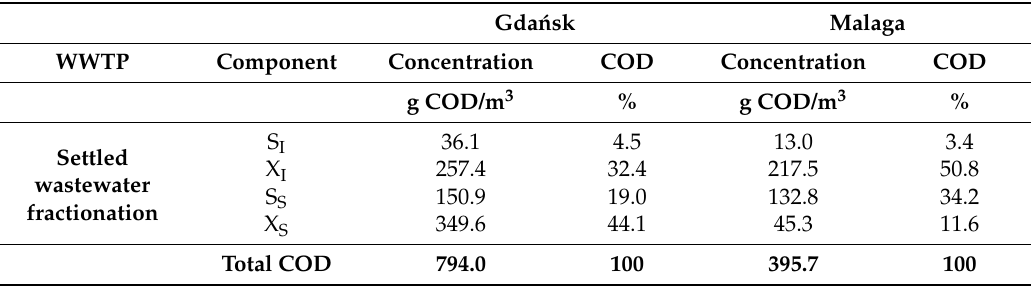
Table 2. Results of the average COD (chemical oxygen demand) fractionation in the settled wastewater at the Gda´nsk/Malaga WWTPs (wastewater treatment